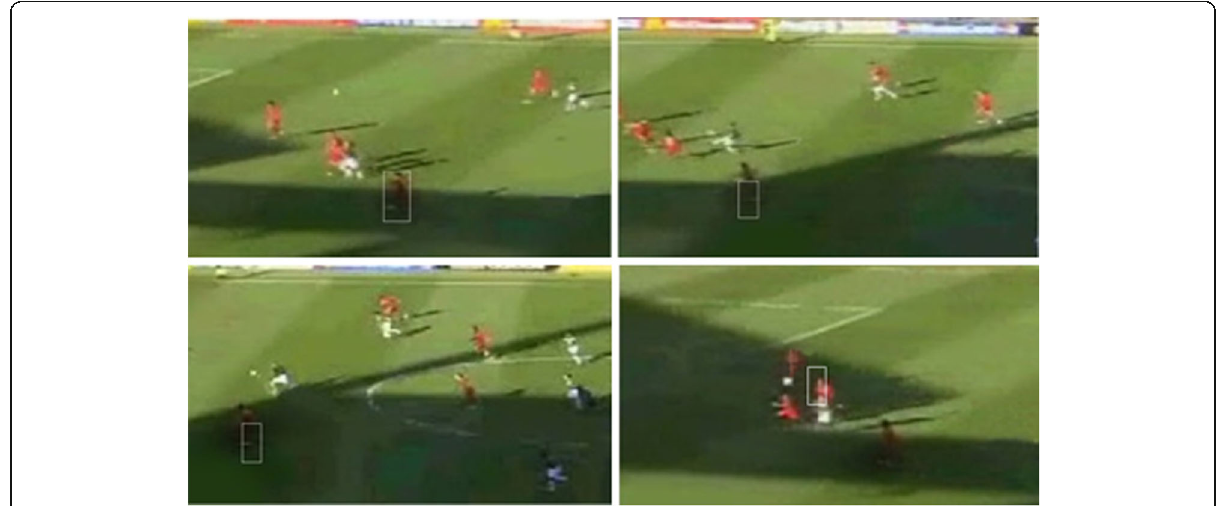
Fig. 9 Performance of mean-shift algorithm in object tracking